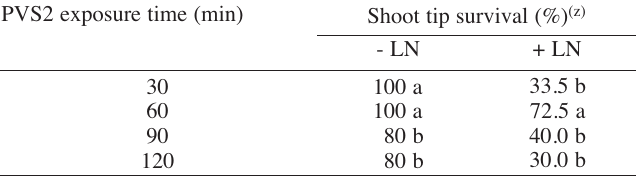
(z) In each column, percentages followed by different letters are signi- ficantly different at P ≤ 0.05 by the post hoc Multiple Comparison test. Table 3 - Effect of sucrose concentration in preculture medium (two days at 4°C) on ‘Rosso di Chioggia’shoot tips cryopreserved following 60 min PVS2 treatment